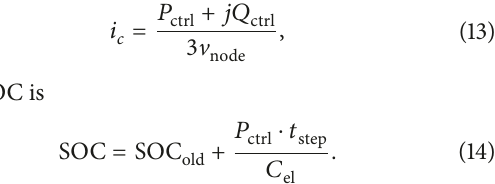
, the input out ,𝑝